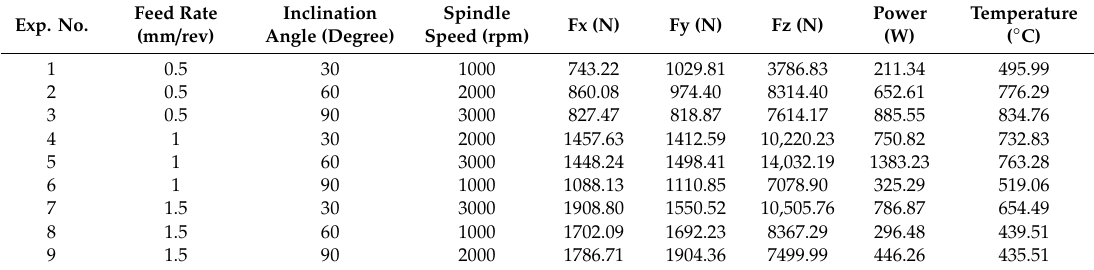
Table 4. Taguchi’s L9 orthogonal array responses of cutting forces, power, and temperature. Exp.